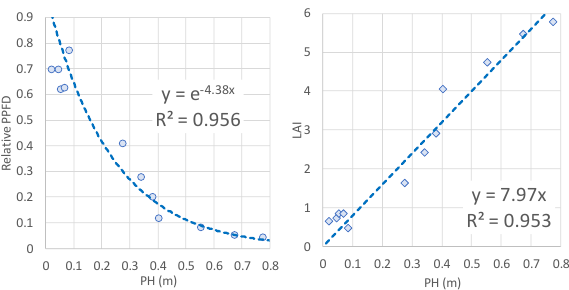
Figure 9. Relations of relative PPFD and LAI with